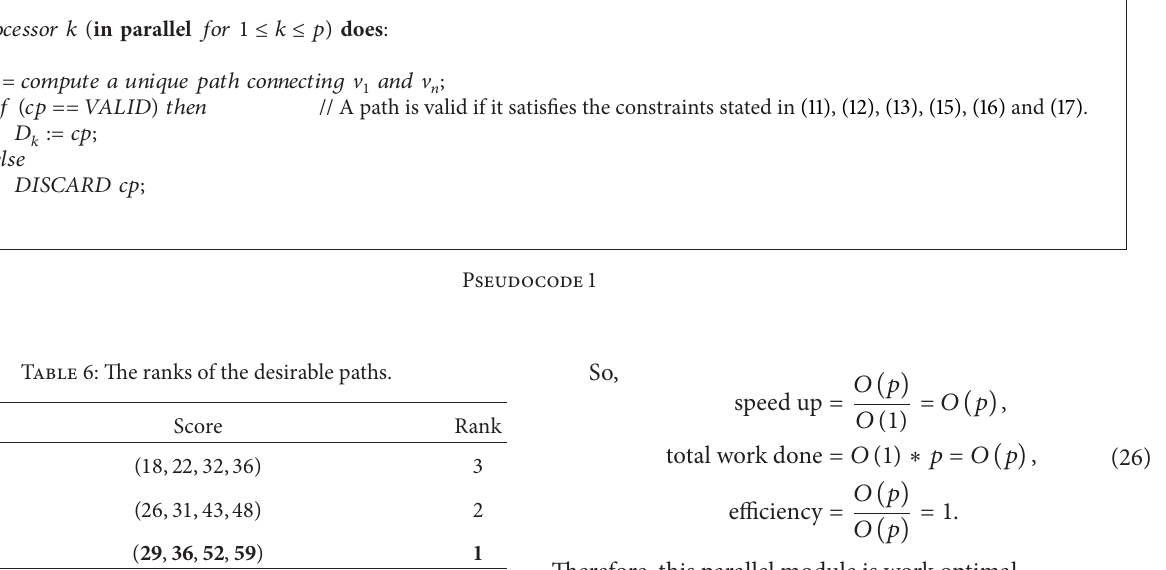
Figure 5: Several steps of the parallel formulation of FOP.